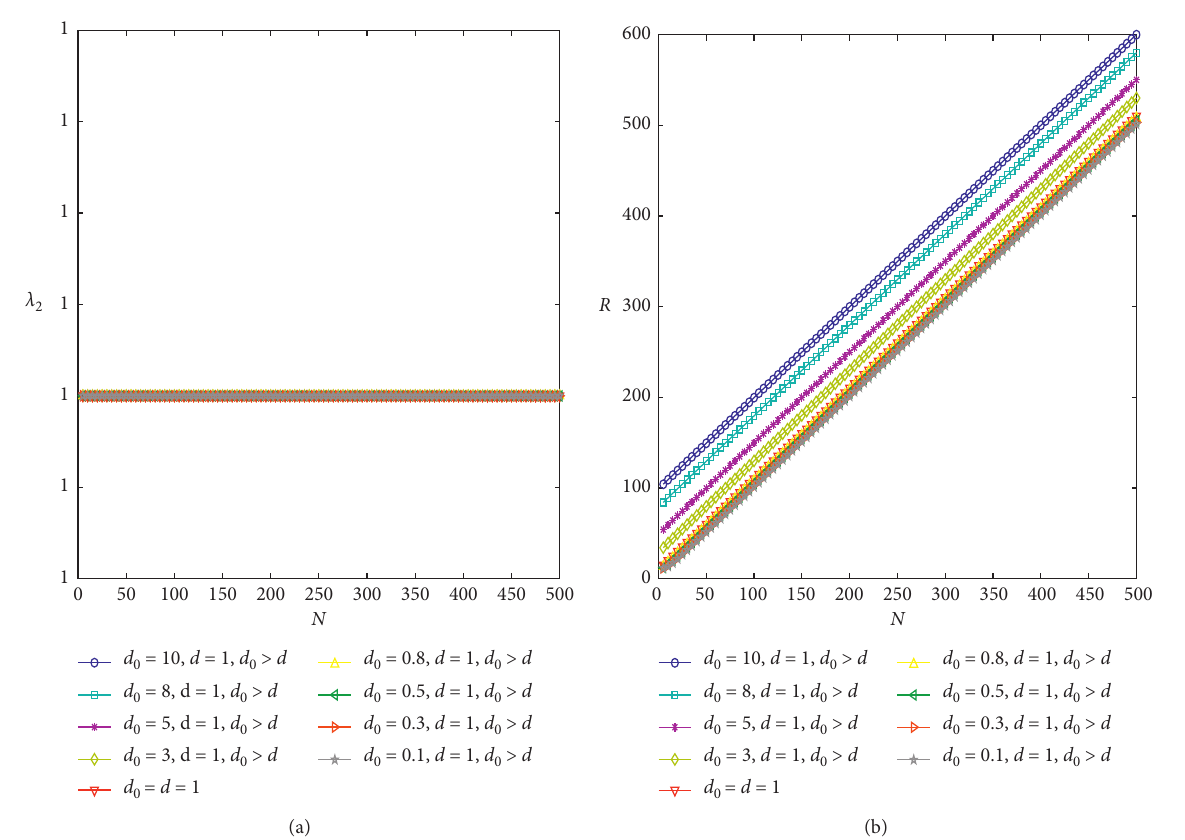
Figure 2: The synchronizability of multilayer star networks vs . varying the number of nodes N ( a � 1, M � 10, d � 1, and a < Md ). (a) λ respect to varying N for different d 0 . (b) R with respect to varying N for different d 0